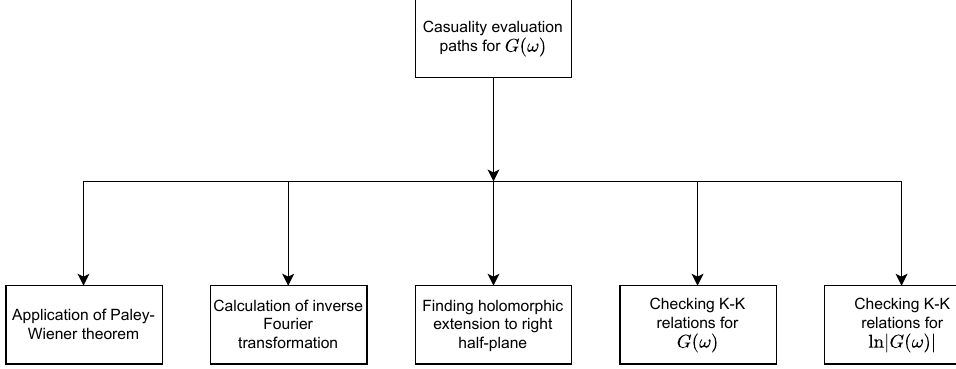
Figure 1. Approaches to causality